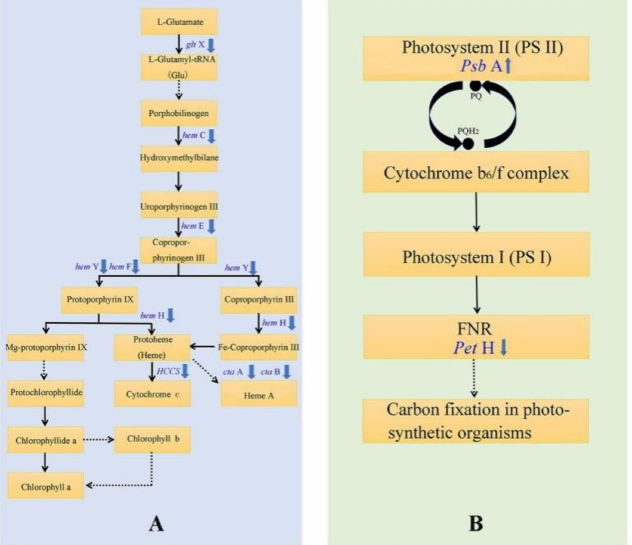
Figure 6. Genes involved in pathways related to the yellow leaf mutant of Torreya grandis ‘Merrillii’. ( A ), The porphyrin and chlorophyll metabolic pathway; ( B ), the photosynthetic